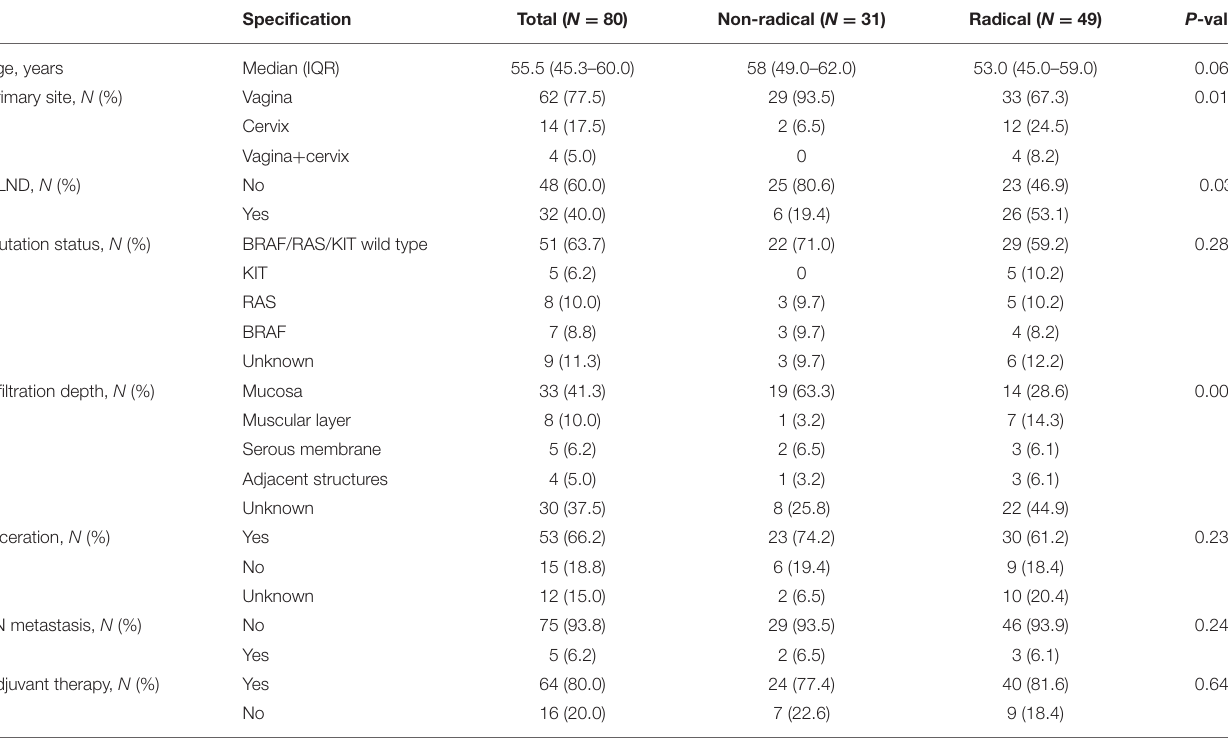
TABLE 1 | Patient demographics and tumour